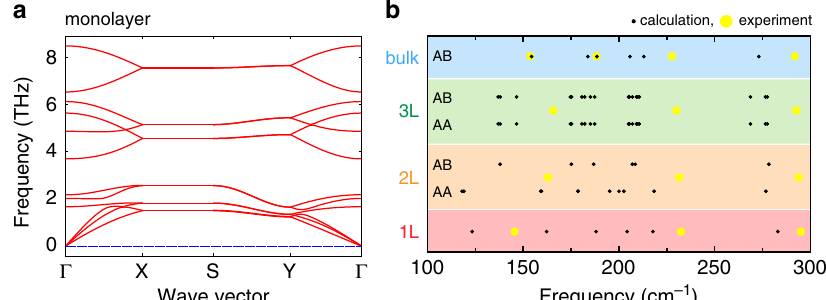
Fig. 3 Theoretical calculation of phonon dispersion and Raman active modes. a Phonon dispersion of the monolayer SnS. b Comparison of calculated Raman active modes and experimental Raman peak positions for SnS with different thicknesses (monolayer, bilayer, trilayer, and bulk) and stacking sequences (AA and